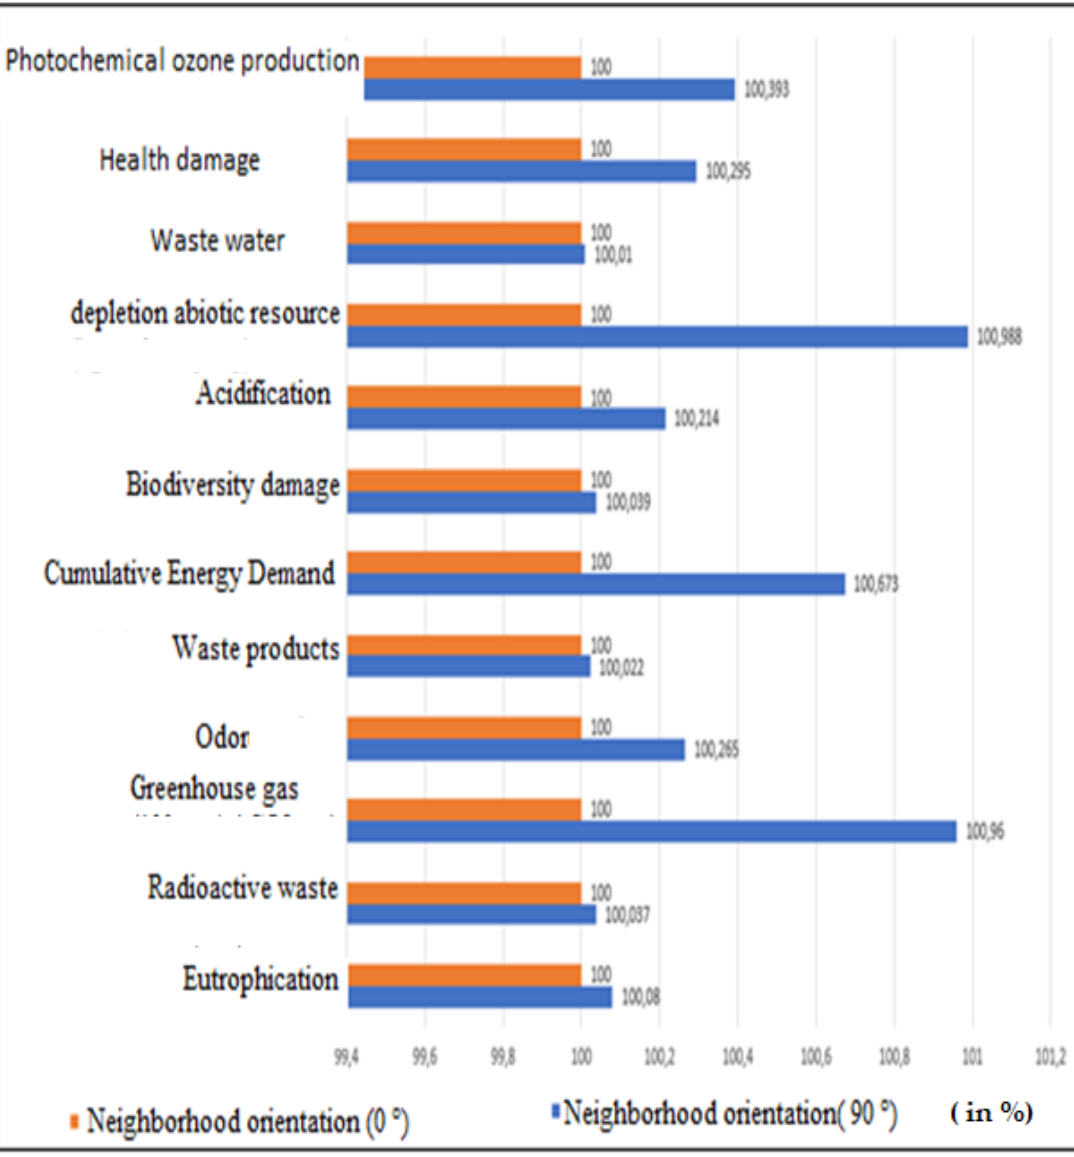
Figure 8. Comparison of the environmental impacts of the “0° orientation” and “90° orientation” scenarios (functional unit: entire neighborhood), in percentage.